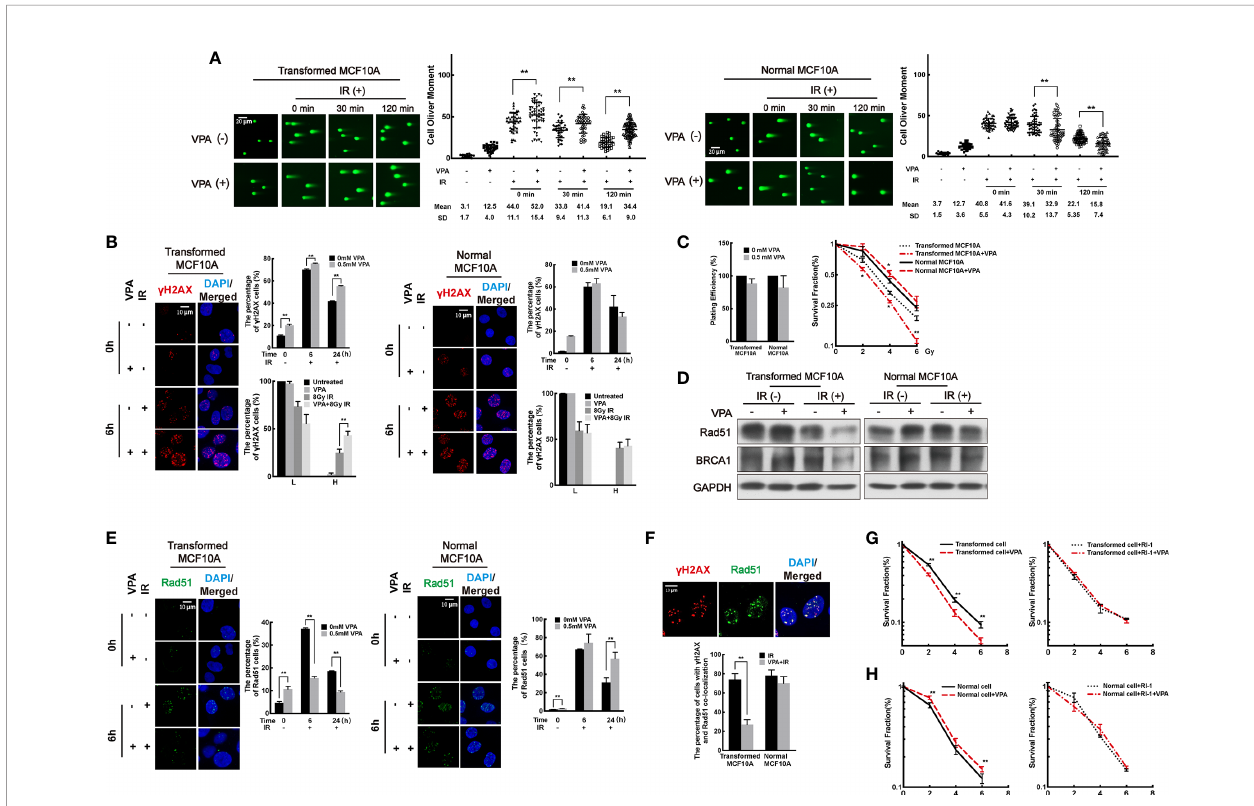
FIGURE 2 | VPA sensitizes transformed cells while protects normal cells after IR treatment by regulating the Rad51-mediated HR pathway. (A) Transformed cells (left panel) and normal cells (right panel) were pretreated with VPA for 24 h and then subjected to 8 Gy IR. The DSB levels of cells at the indicated time points post-IR were detected by neutral comet assay. (B) Immuno fl uorescence staining of g H2AX foci at 6 and 24 h post-IR. The percentage of L-type and H-type cells containing g H2AX foci was showed in the graph. (C) The survival of transformed and normal cells was detected by colony formation assay. (D) At 6 h post-IR, transformed and normal MCF10A cells were subjected to Western blotting. (E) Rad51 foci formation by immuno fl uorescence. (F) At 6 h post-IR, the percentage of g H2AX and Rad51 colocalized cells were showed in the graph. The colony formation and graph showed the cell survival both in (G) transformed and (H) normal cells under RI-1 inhibition on Rad51. Each data point in the graph was from three independent experiments (mean ± SD); P -values were calculated by t-test (* P < 0.05, ** P <